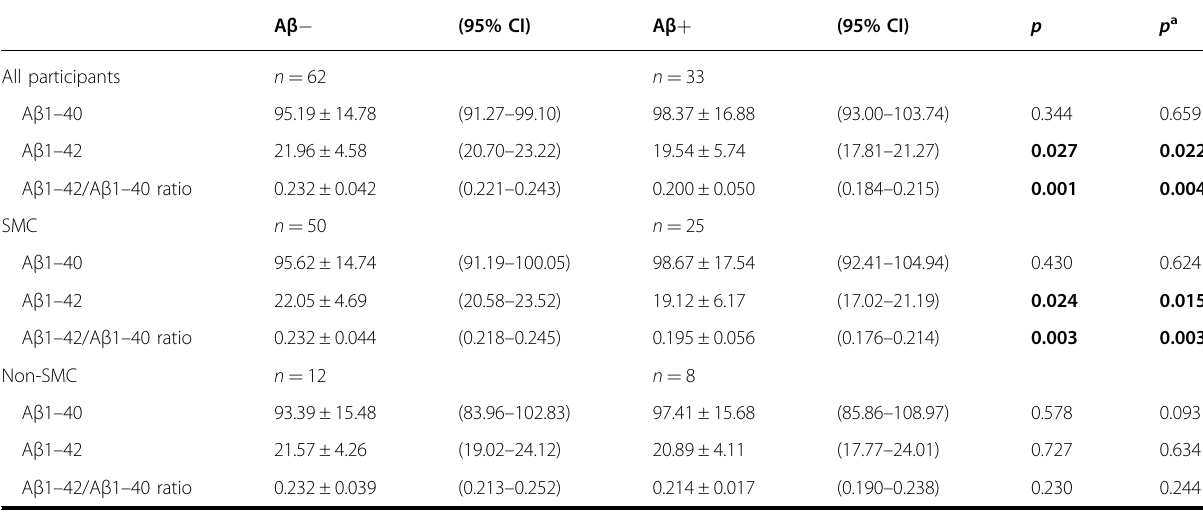
Table 3 Comparison of plasma A β 1 – 40, A β 1 – 42, and A β 1 – 42/A β 1 – 40 ratios between A β − and A β +